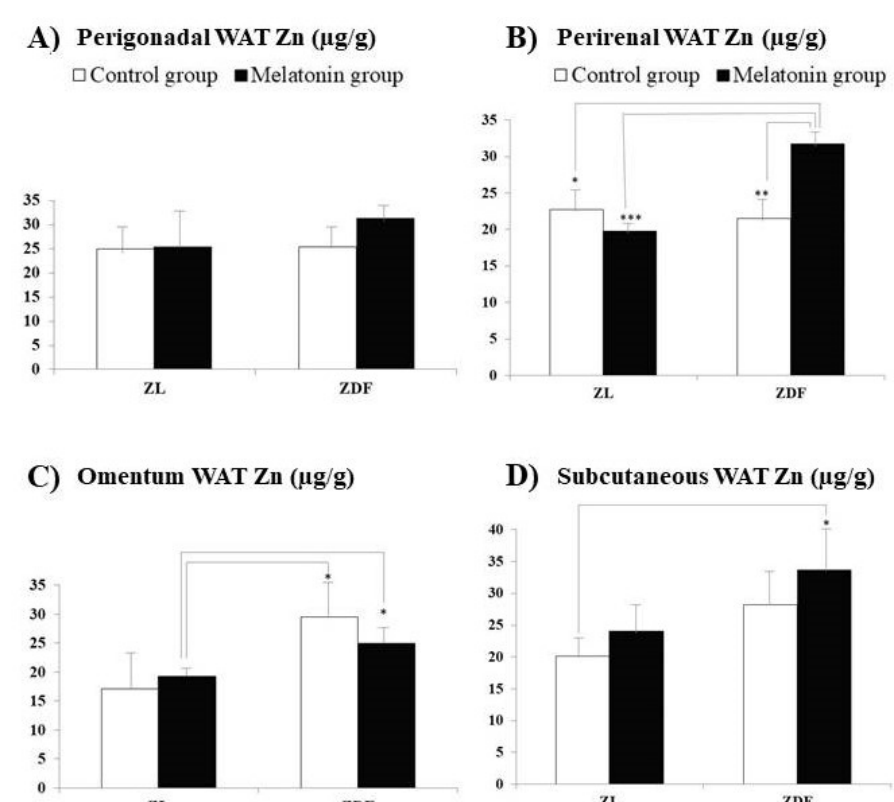
Figure 2. Influence of melatonin supplementation in Zn levels of white adipose tissues (WAT) in male Zücker lean and diabetic fatty rats. ( A ) Gonadal WAT Zn. ( B ) Renal WAT Zn. ( C ) Omentum WAT Zn. ( D ) Subcutaneous Zn. C–ZL: Control lean rats without melatonin; M–ZL: Lean rats with melatonin; C–ZDF: Control diabetic fatty rats without melatonin; M–ZDF: Diabetic fatty rats with melatonin; ZL: Zücker lean rats; ZDF: Zücker diabetic fatty rats. Values are means ± SEM ( n = 10) of ratios of Zn levels. * p < 0.05; ** p < 0.01; *** p < 0.001 (Tukey post hoc test).